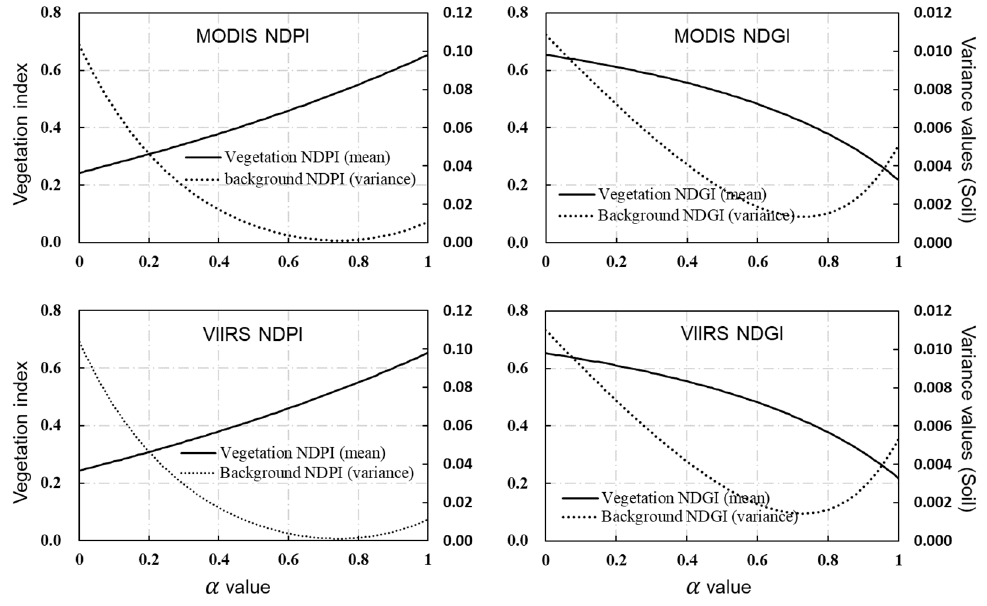
Figure 13. Solid line: the relationship between the VI values for the green vegetation spectra and the α value; Dotted line: the relationship between the variance of background VI values and the α value.